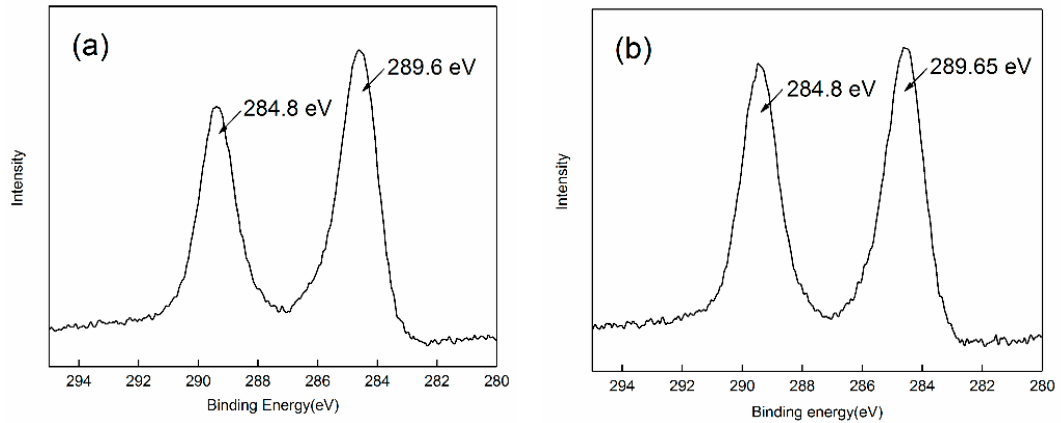
Figure 8. C 1s spectra of ( a ) untreated bastnaesite; ( b ) bastnaesite treated with strontium ions.